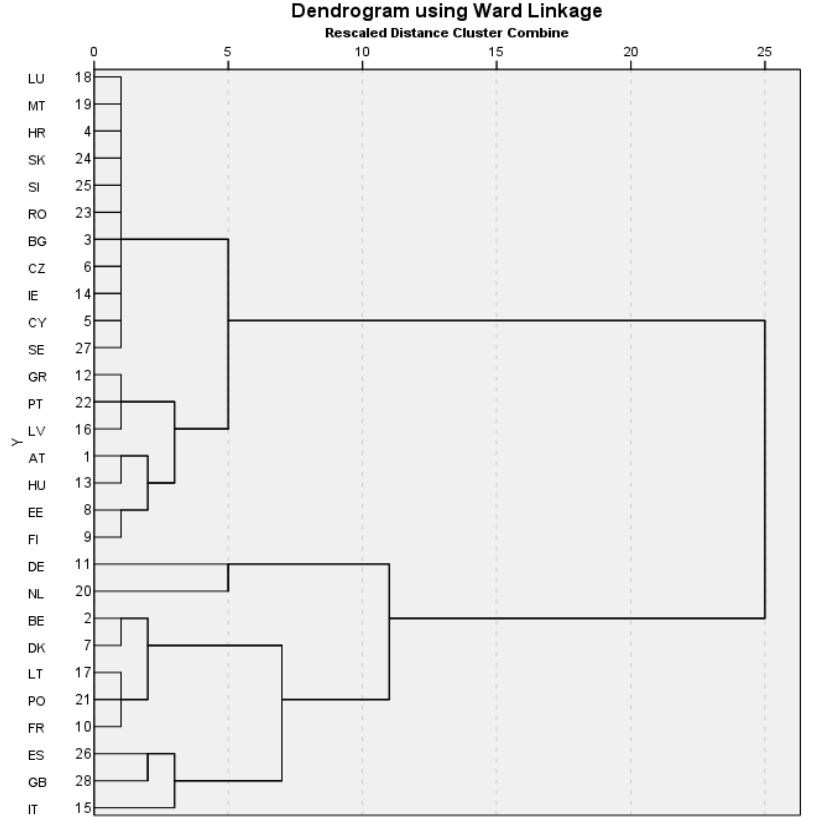
Figure 1. Cluster analysis of the EU28, based on the value of the trade balance with Russia, for the year 2009. Source: Authors’ own calculations based on UN COMTRADE data.